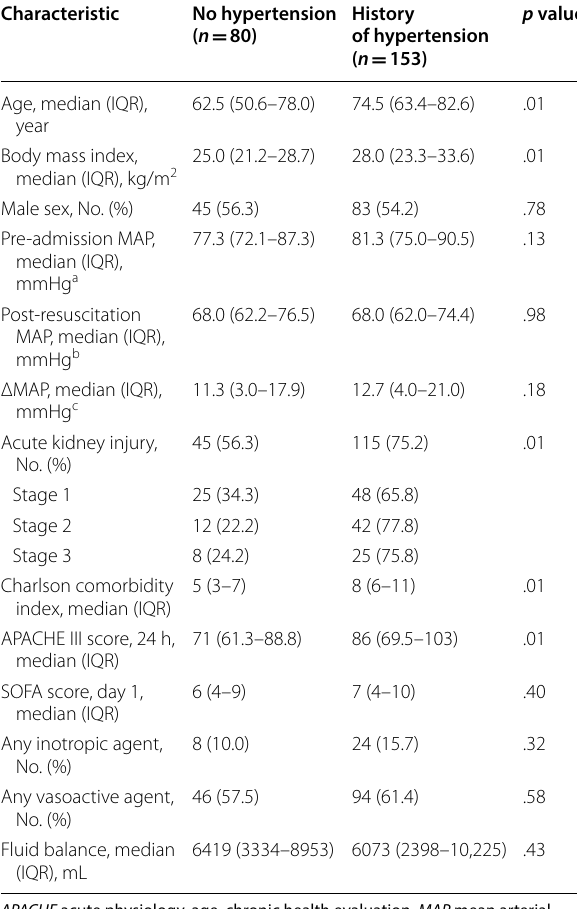
Table 4 Patient characteristics, stratified by history of hypertension ( N =